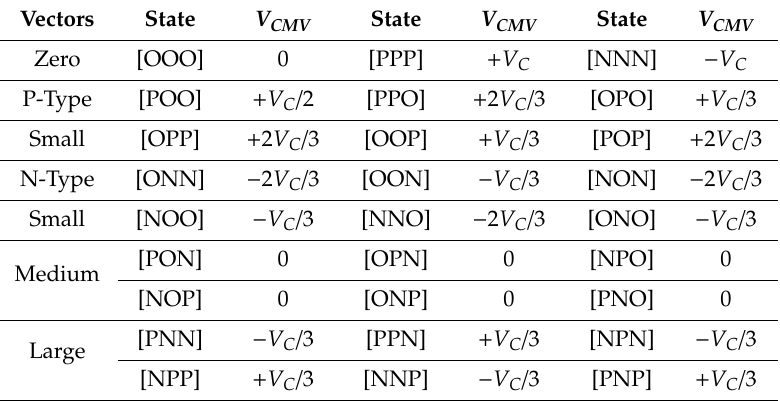
Table 2. Common-mode voltage (CMV) value of the three-level T-type inverter (3LT 2 I).